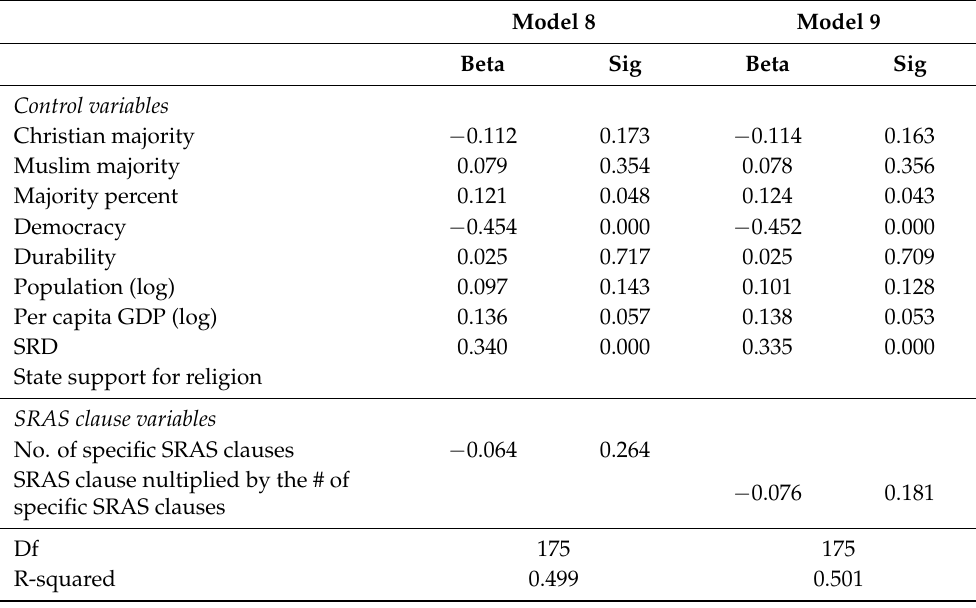
Table 4. OLS regressions predicting the influence of specific SRAS clauses on GRD in 2014.